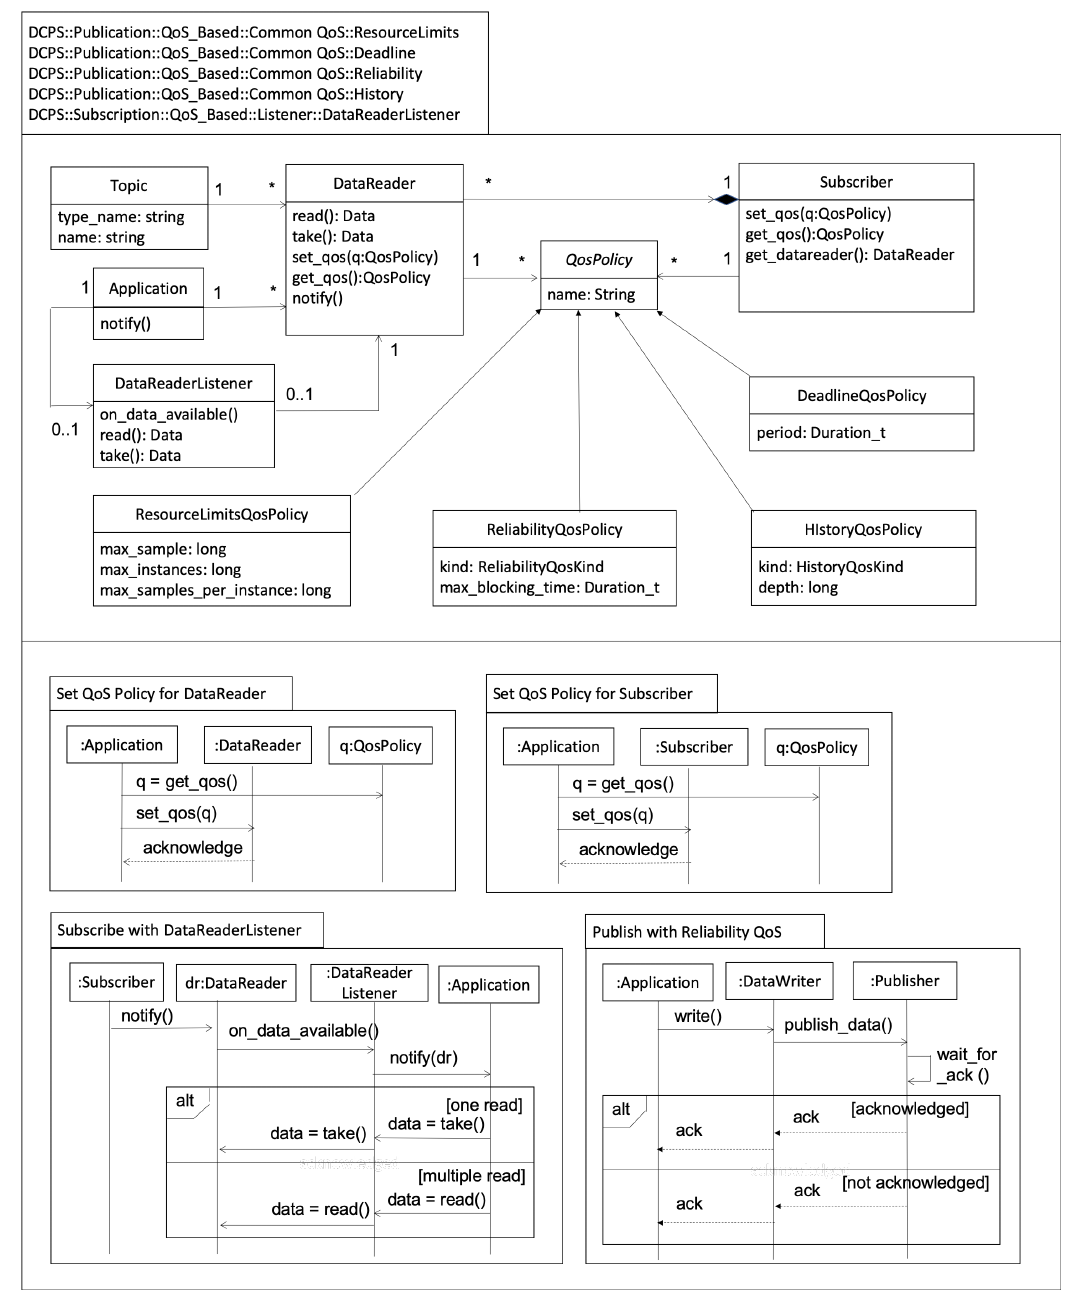
Figure 21. The cf4